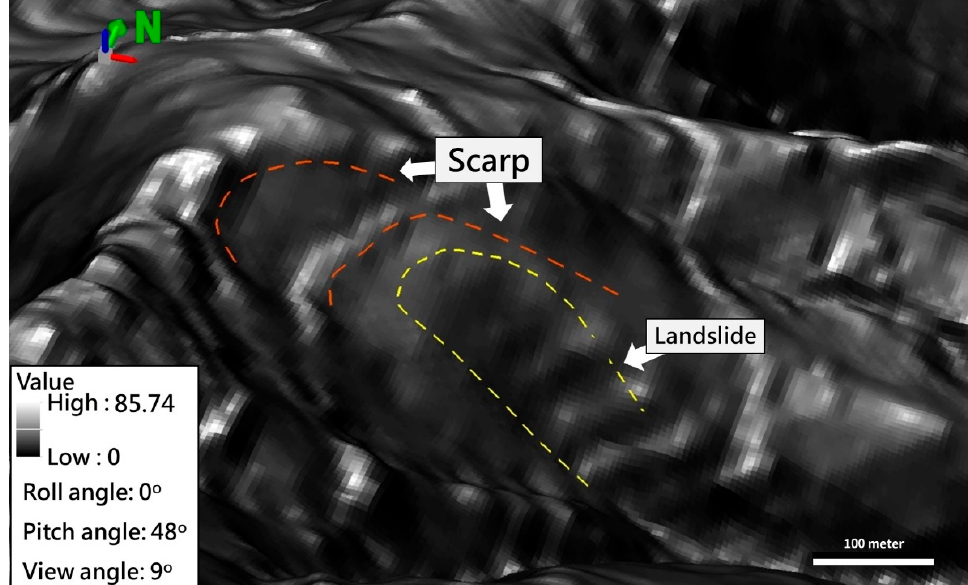
Figure 9. The SPOT5 image after 2005 event was overlaid on three-dimensional slope map of DTM5 viewing from west direction toward east direction, and lineaments of landslide scarp mapped were shown as the colored dash lines.